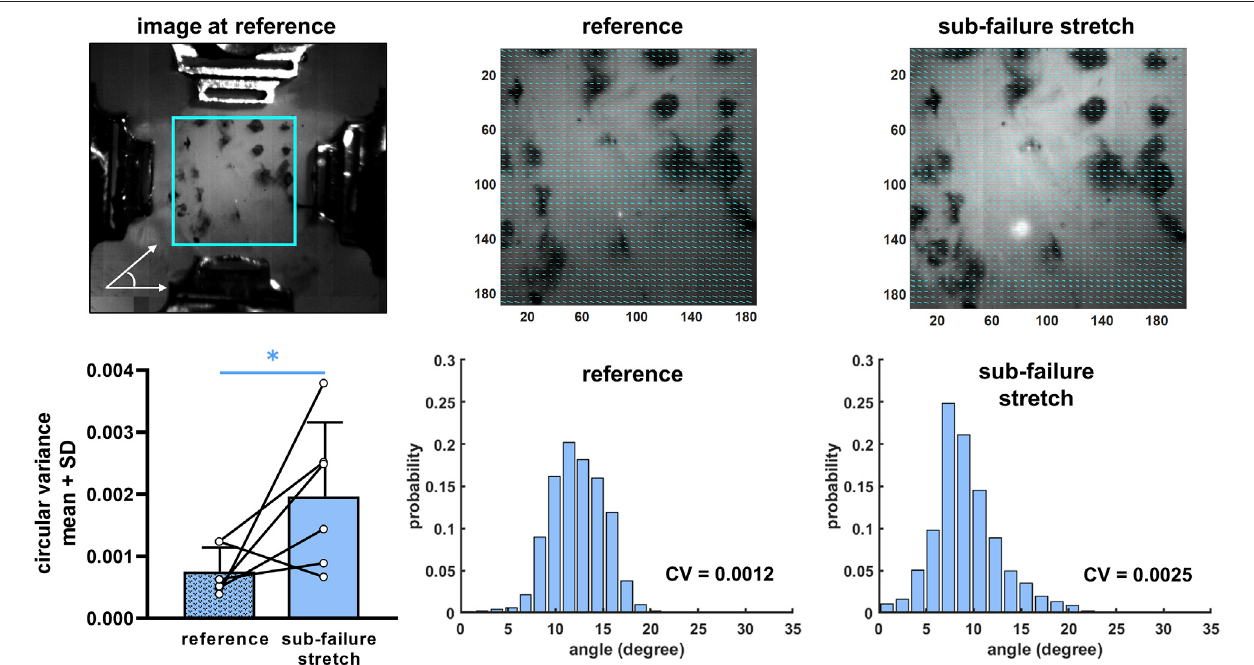
FIGURE3| Sub-failureequibiaxialstretchalterscollagenmicrostructure intheFLS-DRGco-culturegels.Exemplaryhigh-speedimageswithsuperimposedvector maps are shown displaying the pixel-wise raw fi ber alignment; angles are relative to the horizontal, as marked in the image on the left. Histograms for gel S03 show the probability that collagen will orient at a given angle for both the reference state and at the point when peak force is detected for the sub-failure stretch. The stretch signi fi cantly increases the circular variance ( p = 0.031; matched paired t -test, n = 6) indicating fi ber reorganization during loading. Superimposed data points represent quanti fi cation for each gel and CV = circular